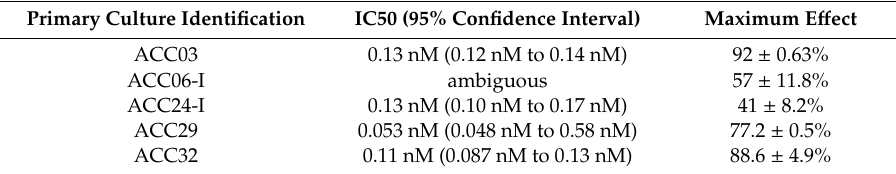
Table 1. E ff ects of trabectedin in ACC primary